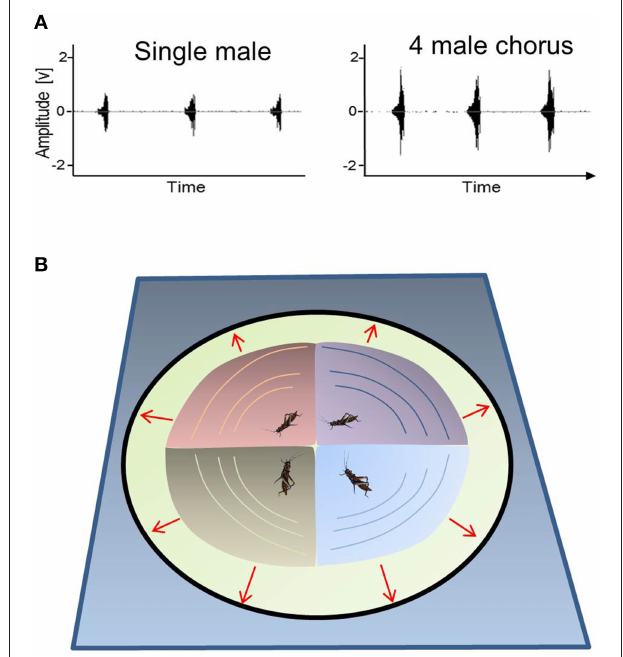
FIGURE 4 | Signal overlap in M. elongata and model of the extension of acoustic space as the result of chorus synchrony. Four males singing in synchrony overlapped their periodic signals to a high degree. This led to a strong increase in signal amplitude (A) and to the enlargement of acoustic space (B) . In this way, a group of synchronized males can attract females from a greater distance as compared to lone singing males. In the case of signal alternation, the area in which a single male signals at higher amplitude as compared to its competitors is strongly reduced (shown as areas with different